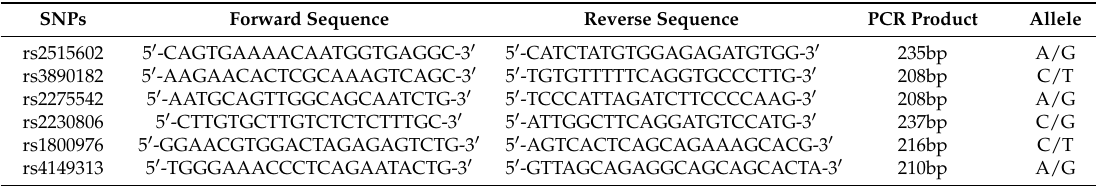
Table 1. Sequences of forward and reverse primers to genotype the ABCA1